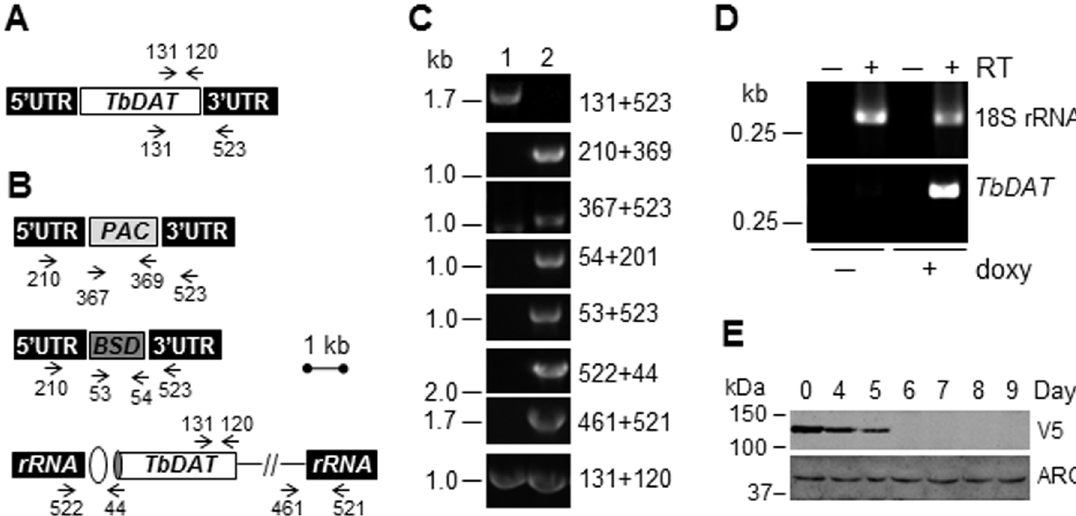
Fig 4. Generation of a conditional null mutant of TbDAT in T . brucei . (A) Wild-type organizationof the TbDAT allele. (B) Genotype of the conditional null mutant Δ tbdat/ Δ tbdat/TetO : V5 : TbDAT that expresses a V5-tagged(grey oval) versionof Tb DAT that is regulatedby the TetO promotor (white oval) and insertedinto the intergenicregionof the ribosomal RNA locus. Both TbDAT geneswere replaced with the resistancecassettes blasticidin( BSD , dark grey rectangle) and puromycin( PAC , light grey rectangle). (C) Agarose gel electrophoresis of PCR analysisof the conditional null mutant Δ tbdat/ Δ tbdat/TetO : V5 : TbDAT . The position of the primers used here is depicted in (A) and (B). (D) RT-PCR analysisof strain Δ tbdat/ Δ tbdat/TetO : V5 : TbDAT . RNA was isolated from strain Δ tbdat/ Δ tbdat/TetO : V5 : TbDAT grown in the presence(+) or absence( − ; 10 days) of doxycycline (doxy) that was (+) or was not ( − ) subjectedto the reverse transcriptase reaction(RT). Amplification of the 18S rRNA cDNA was used as a positive control. (E) Western blot analysesin the presence of anti-V5 (Thermo Fisher Scientific, Waltham, MA) to reveal V5: Tb DAT and arginase specific antibodies(ARG; [43]) as a loadingcontrol. Approximately 1x10 7 cell equivalent was loadedin each lane. The protein marker is shown on the left. The Western blot analysiswas carried out twice and a representative experiment is shown.